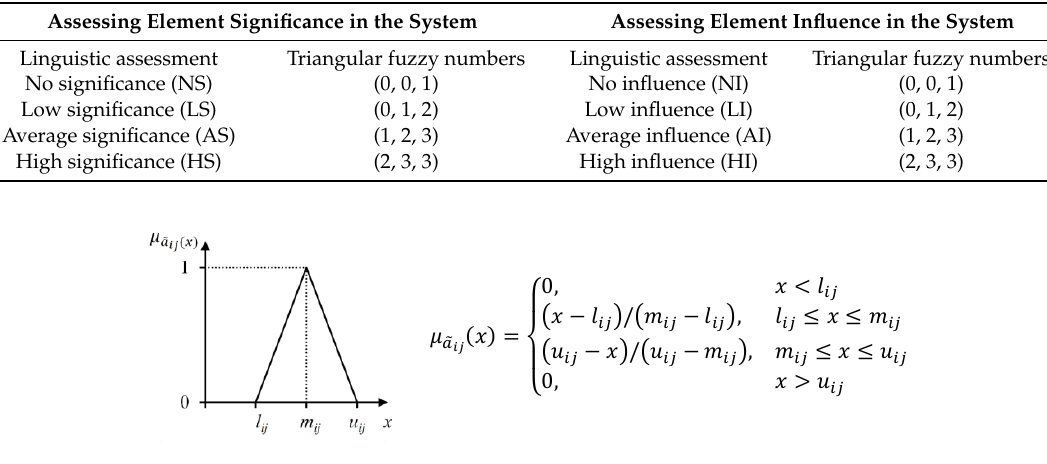
Figure 3. A representation of a linguistic opinion of an expert in the form of a triangular fuzzy set [29]. Table 1. Linguistic assessment of element significance and influence and their representation as triangular fuzzy sets, based on [29].